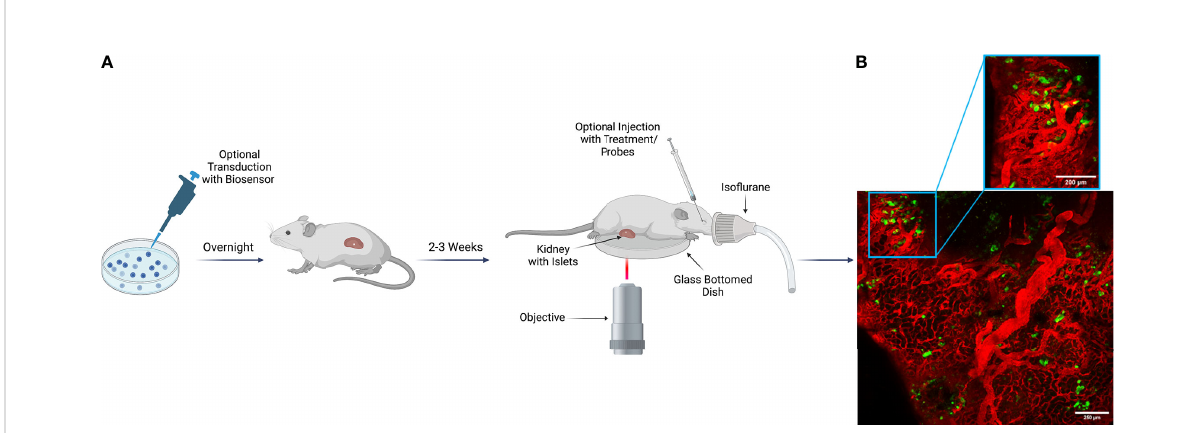
FIGURE 2 Imaging Scheme for Intravital Imaging of Transplanted Human Islets Under the Kidney Capsule. (A) Human islets isolated from a cadaveric donor can be transduced with a virally packaged biosensor as desired to visualize function in vivo . Transduced islets then remain in viral media overnight to gain optimal biosensor expression before transplantation into a recipient animal the following day. If the experimental design does not include transduction, islets can be transplanted after overnight recovery from shipment. Following delivery of the islets to the recipient, a 2 – 3-week period is required for islet engraftment and recovery. During this time, the islets become optimally vascularized, and transduced biosensors mature. For terminal imaging experiments, the recipient animal is anesthetized, and the kidney is externalized and sutured for stable positioning during image acquisition. After externalization, the kidney is placed upon a glass bottom dish, and the animal is transferred to the microscope stage. Once upon the stage, various treatments, fl uorescent probes, and antibodies can be injected for evaluation of islet physiology and cellular response to stimuli. Image was created using Biorender.com. (B) Representative example of human islets engrafted into the kidney capsule of an NSG mouse. In both the tiled image of a large region of the pancreas, as well as in the zoomed in view, islet beta cells can be observed expressing a ratiometric biosensor to measure reactive oxygen species under the control of a rat insulin promoter [Ins-GRX1- roGFP2 (25)] with vasculature marked by IV-injected albumin conjugated to